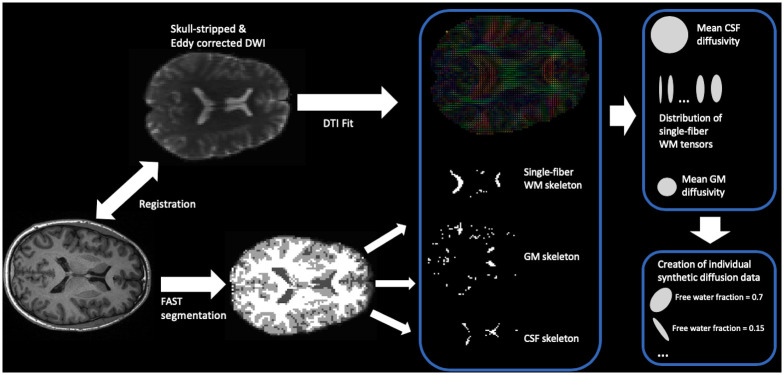
Illustration of the generation of synthetic training data for the individual subject.Gray matter (GM), white matter (WM) and cerebrospinal fluid (CSF) skeletons are extracted from an eroded FAST segmentation map, based on the T1 image. For WM, the map is further reduced to areas where the FA value is higher than 0.7. These tissue maps are then transformed to the diffusion space, where they are used to extract the mean CSF and GM diffusivity, and to sample single-fiber WM voxels. Using the obtained diffusivity values and sample WM voxels, synthetic diffusion data with a known water fraction as well as properties following the characteristics of the individual subject can be created.